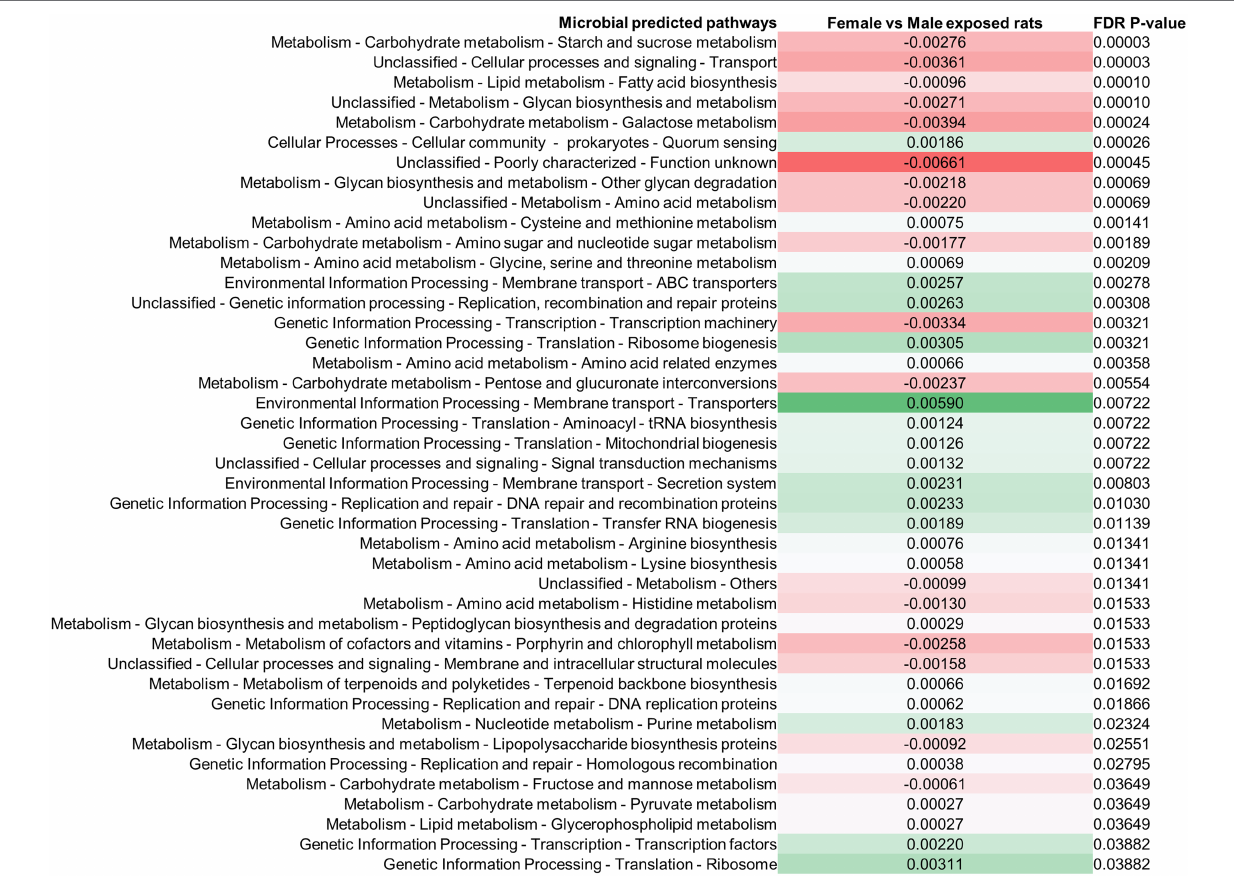
FIGURE 4 | Differences in predicted stool microbial functional metabolic pathways in exposed male and female rats on PAbxD13. Pathways shown in red are predicted to be enriched in exposed males, and pathways shown in green are predicted to be enriched in exposed females. Only significant differences are